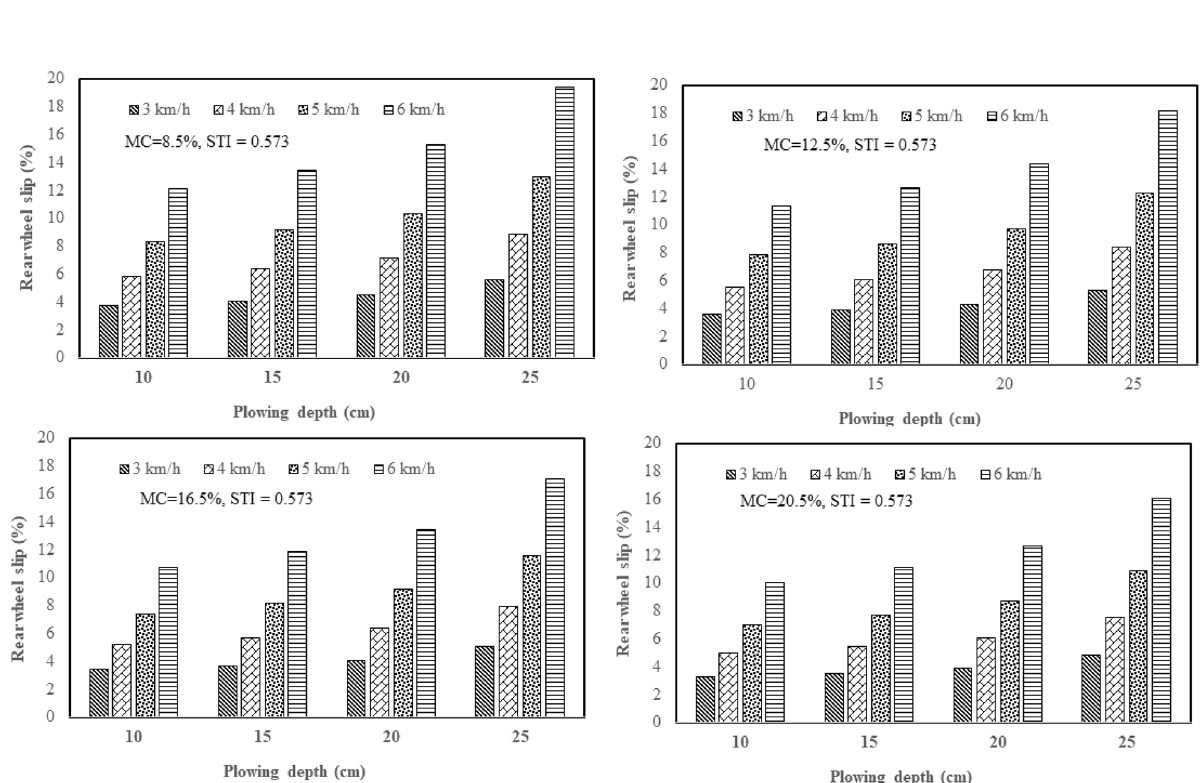
Figure 8. Effect of plowing speed and depth on the tractor rear wheel slip in 2WD mode at different levels of soil moisture content during plowing process by moldboard plow in soil with a texture index of